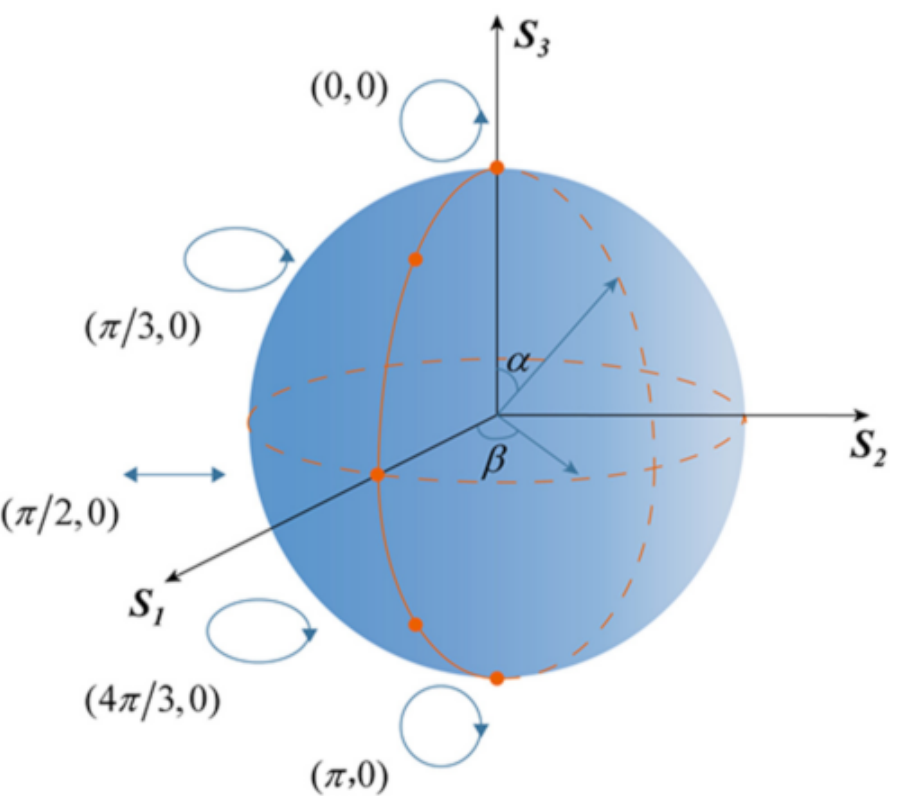
Figure 6. Schematic view of a vector vortex beam with space-dependent polarization distribution and phase profile on the